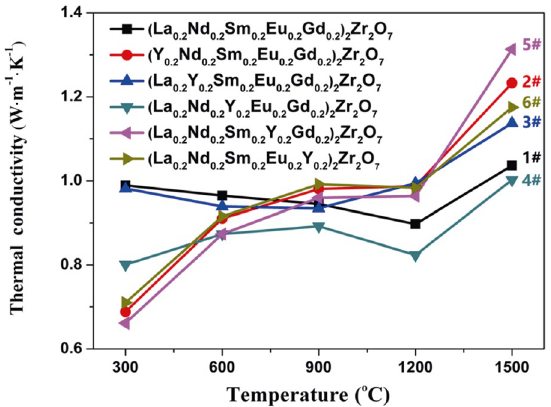
Fig. 5 Thermal conductivity as a function of temperature for the ceramics (1#–6#) after sintering at 1500 ℃ for 3